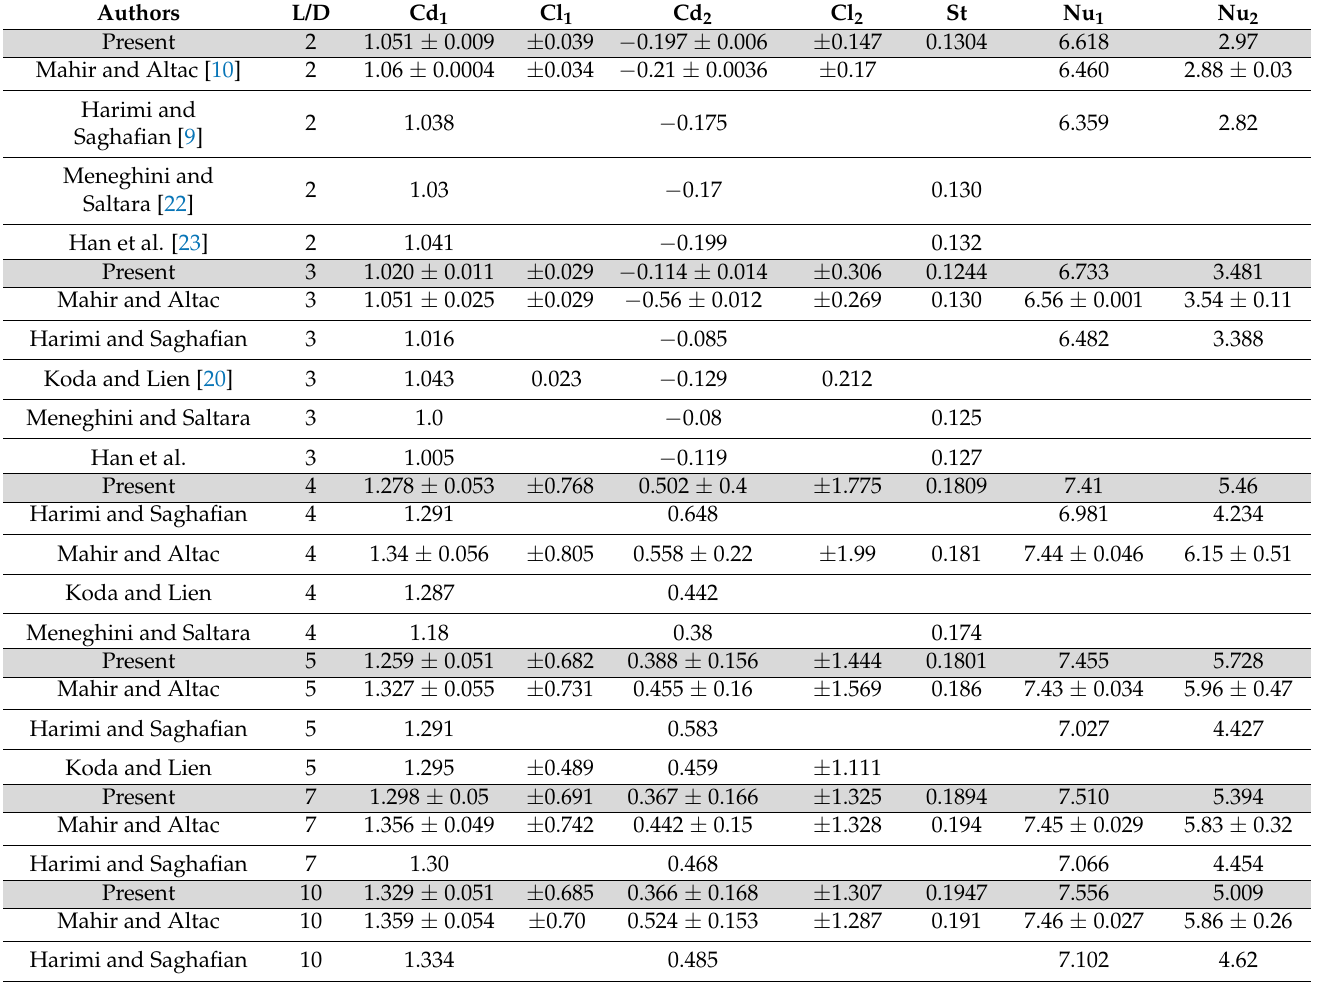
Table 2. Hydrodynamic forces coefficient and Nusselt number of a two-cylinder tandem array for flow at Re = 200.